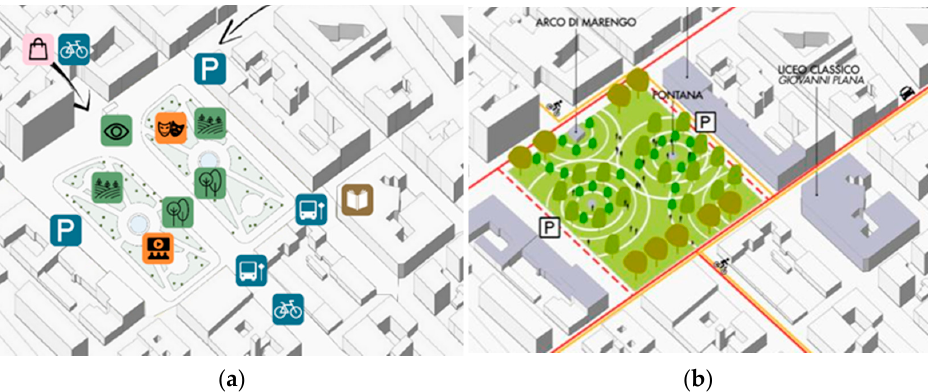
Figure 11. ( a ) The schema brings the strategies proposed in the elaboration phase to the square scale, focusing in particular on the locations of service parking areas and the configuration of the square as an intermodal mobility hub, and on the requalification of the parks, considering three main aspects: the quality of the sightlines, the enhancement of the vegetational elements and the improvement of permeable surfaces, and on the activation of spaces for cultural events; ( b ) the strategies mentioned above are turned into a proposal for a transformation scenario [Source: Authors].